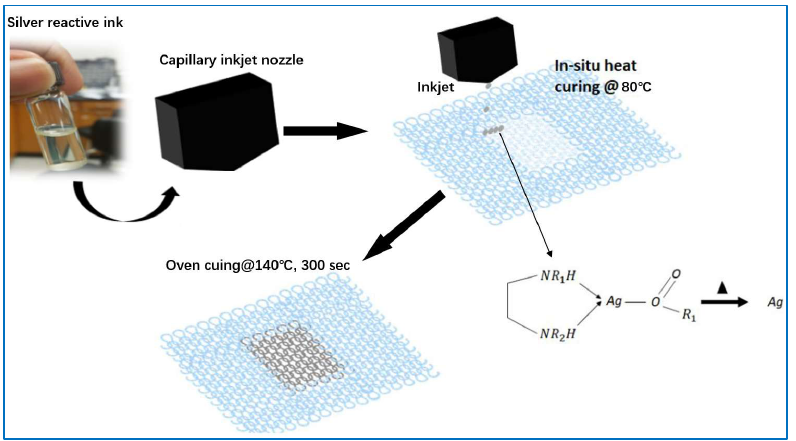
Figure 2. Schematic diagram of spray-coating